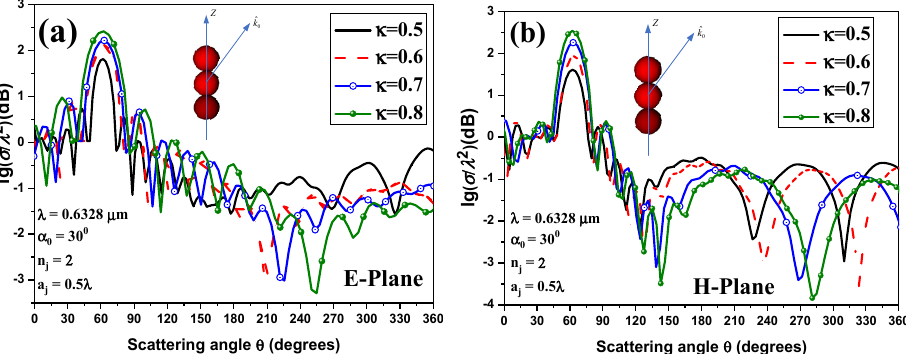
Figure 8. ( a ) Angular distributions of normalized RCS with varying chiral parameters κ versus scattering angle irradiated by an RCP HOBB. ( a ) E-plane; ( b ) H-plane.